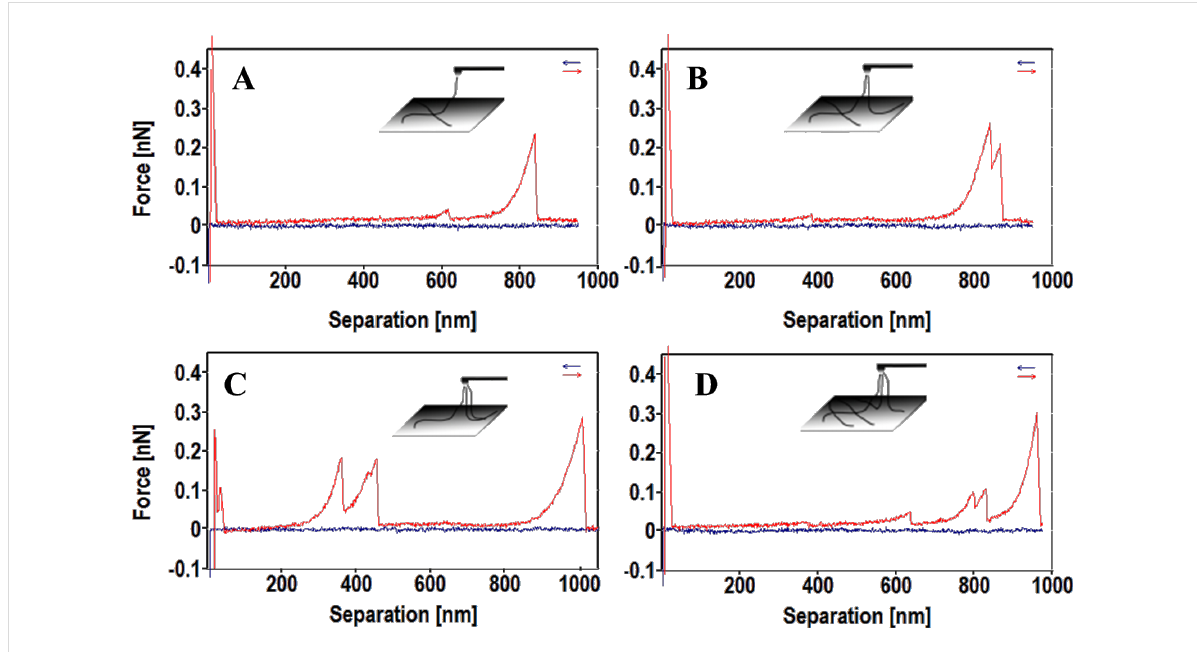
Figure 7: Mechanical responses composited by different type force curves. A) t 1 + t 2 . B) t 2 + t 3 . C) t 1 + t 3 . D) t 2 + t 2 + t 1 + t 3 .